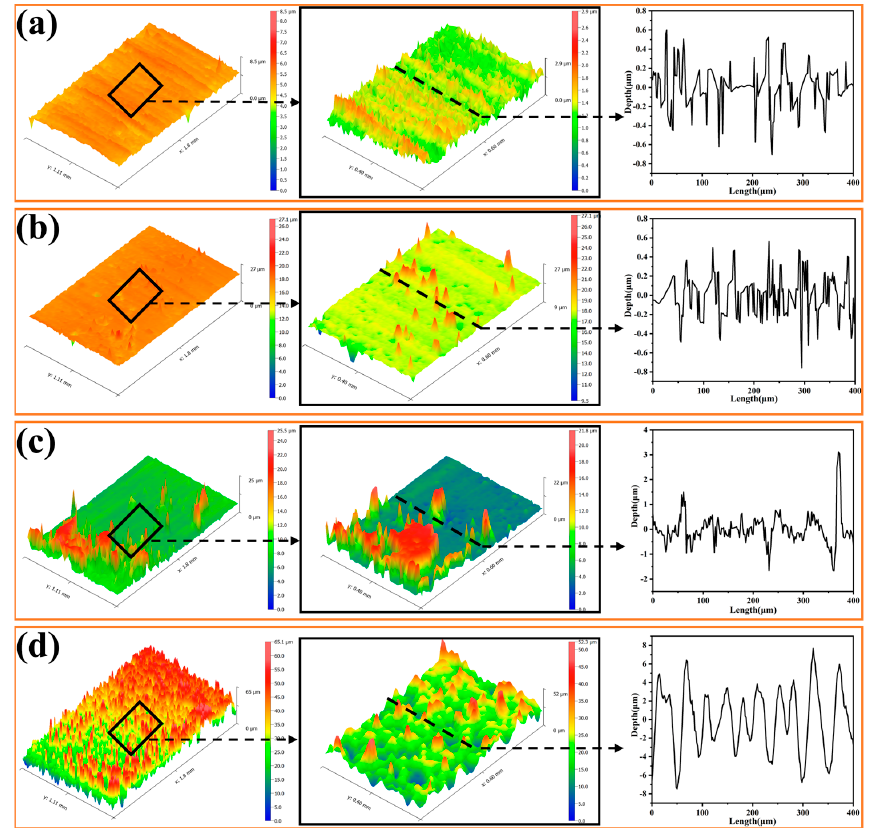
Figure 8. 3D morphology and 2D profiles of E-MTES coatings at different deposition times: ( a ) 100 s; ( b ) 200 s; ( c ) 400 s; ( d ) 600 s. Roughness Sa values are 0.203 ± 0.0288 μ m, 0.438 ± 0.079 μ m, 2.17 ± 0.271 μ m and 8.29 ± 0.829 μ m, respectively.